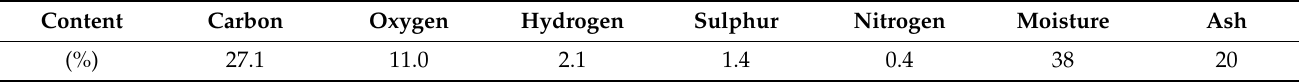
Table 2. Thar coal